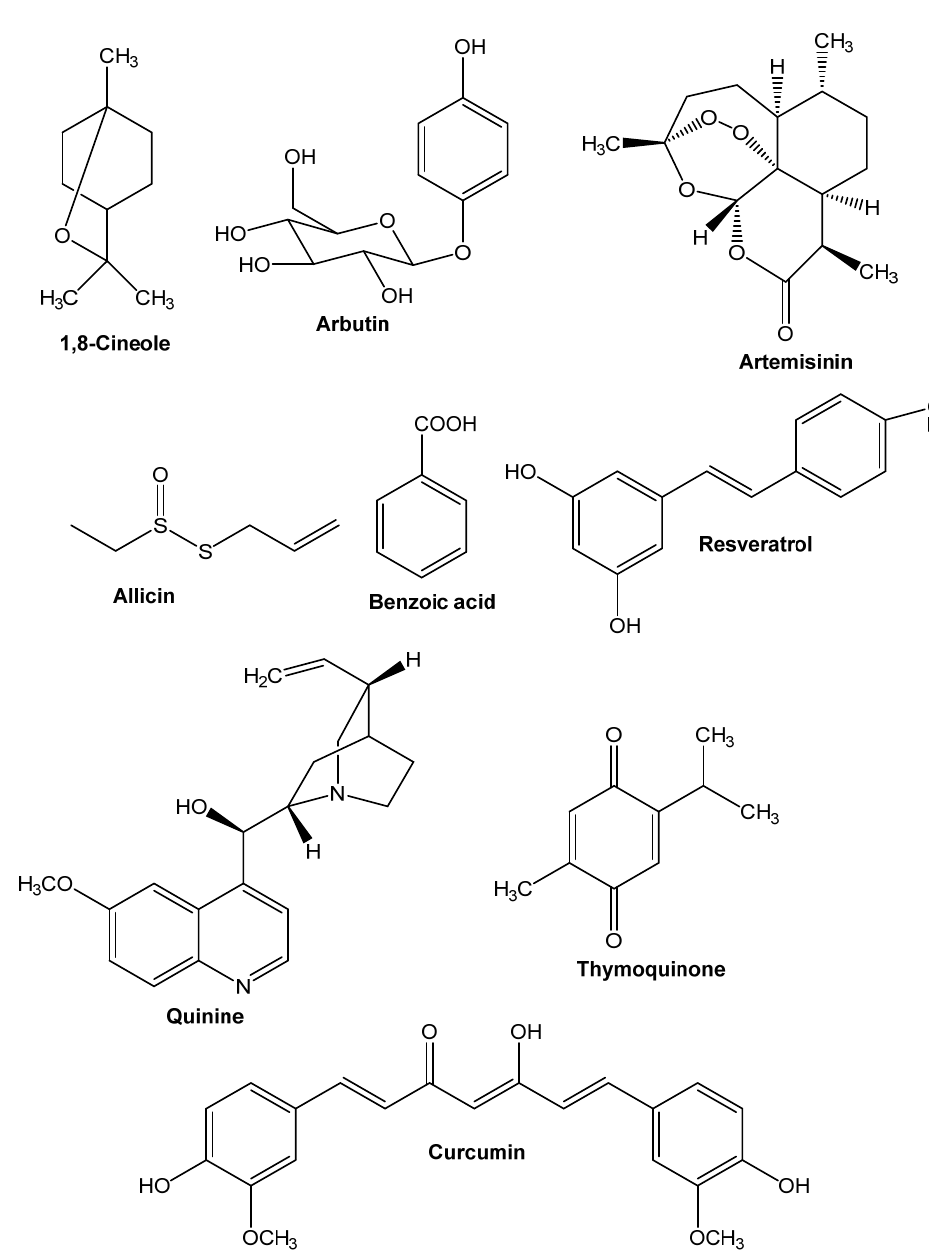
Figure 2. Secondary metabolites presented significant antimicrobial properties from medicinal plants and phytochemicals. and